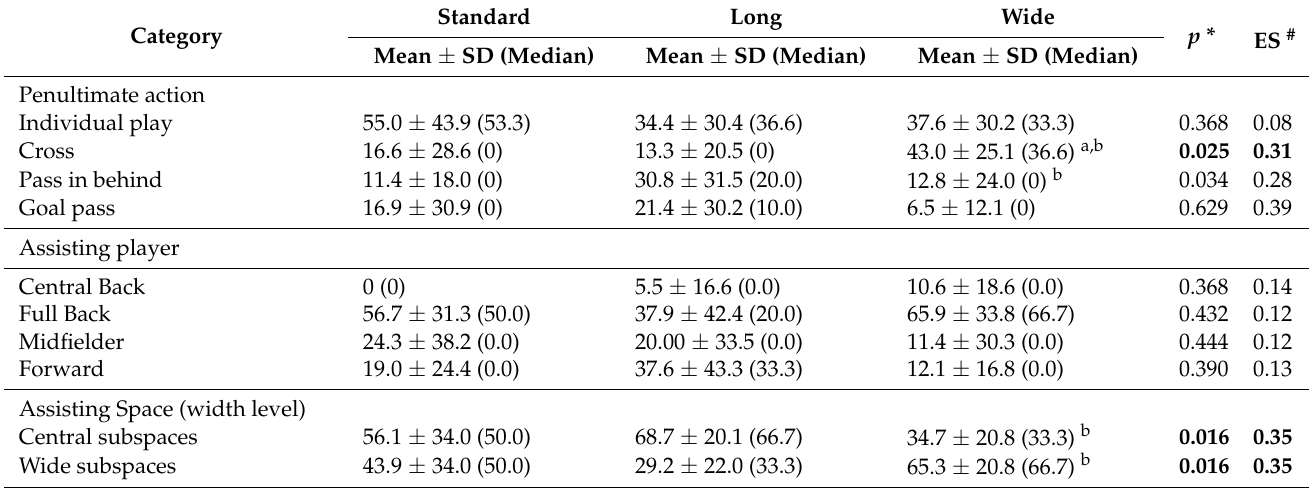
Table 6. Comparison of the penultimate action between the three different pitch configurations in the team possessions that led to